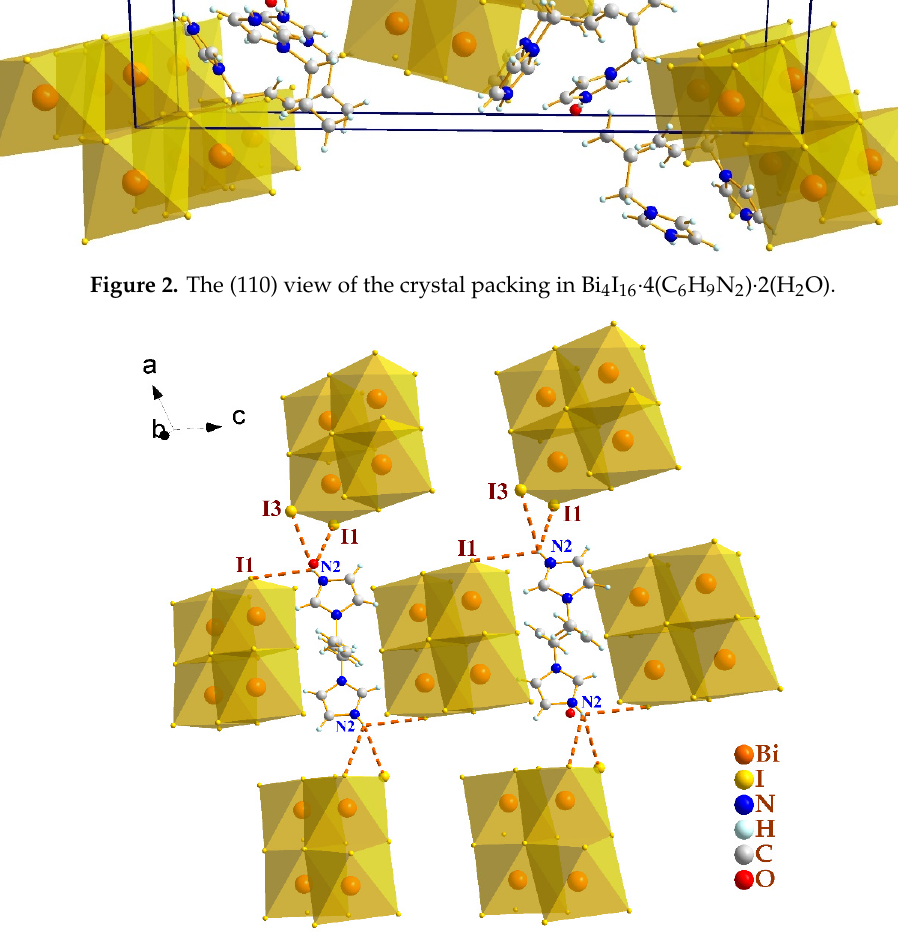
Figure 3. The hydrogen-bonding scheme of Bi 4 I 16 · 4(C 6 H 9 N 2 ) · 2(H 2 O).